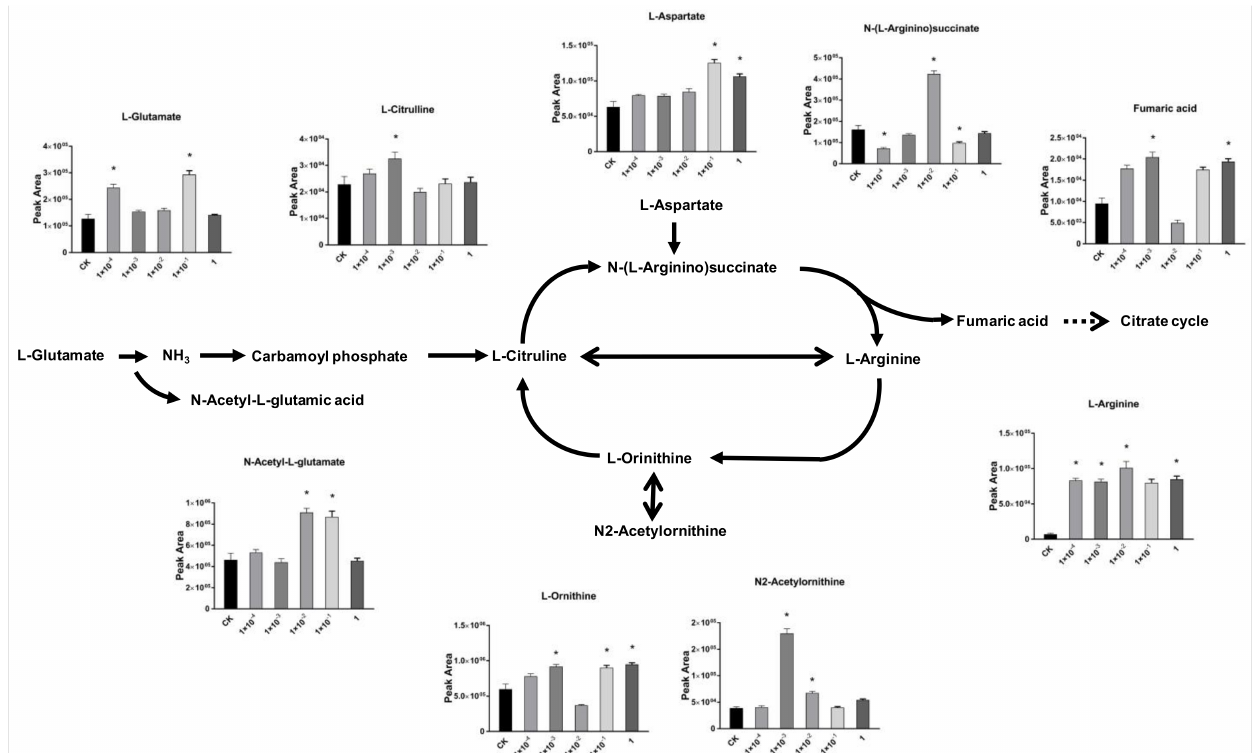
Figure 6. Schematic representation of the urea cycle exposed to Dufulin in Tubifex. Error bars indicate standard deviation (SD). (*: p <